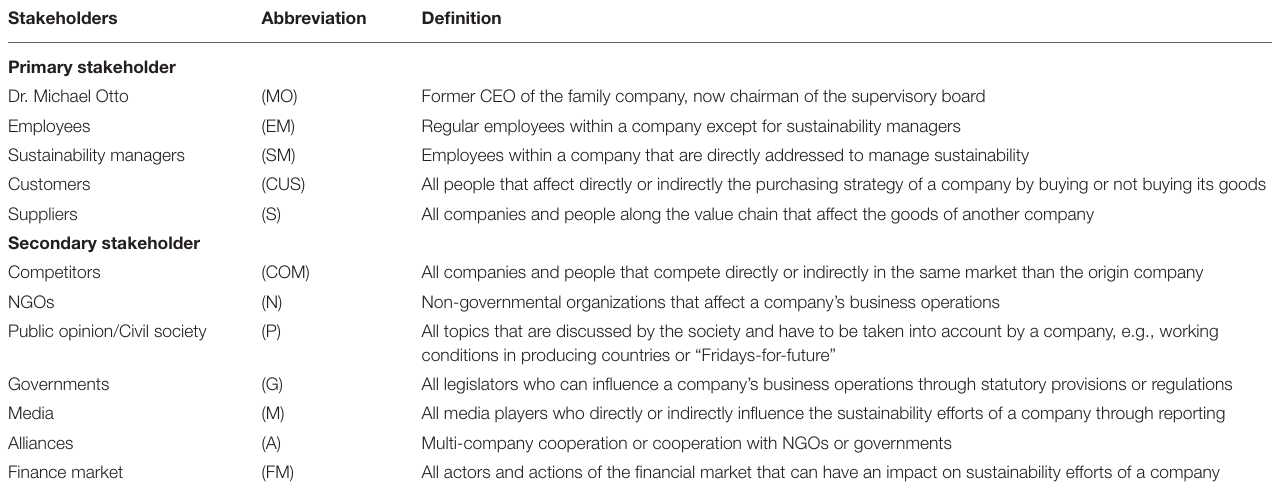
TABLE 3 | Inductively identified stakeholders with definitions based on Busse et al.